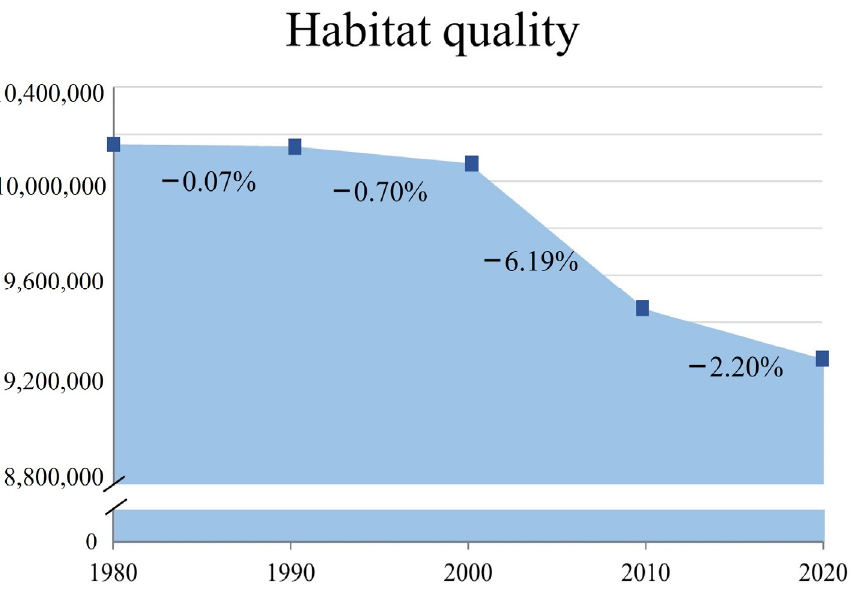
Figure 7. The temporal change in total value of HQ of Wusu.